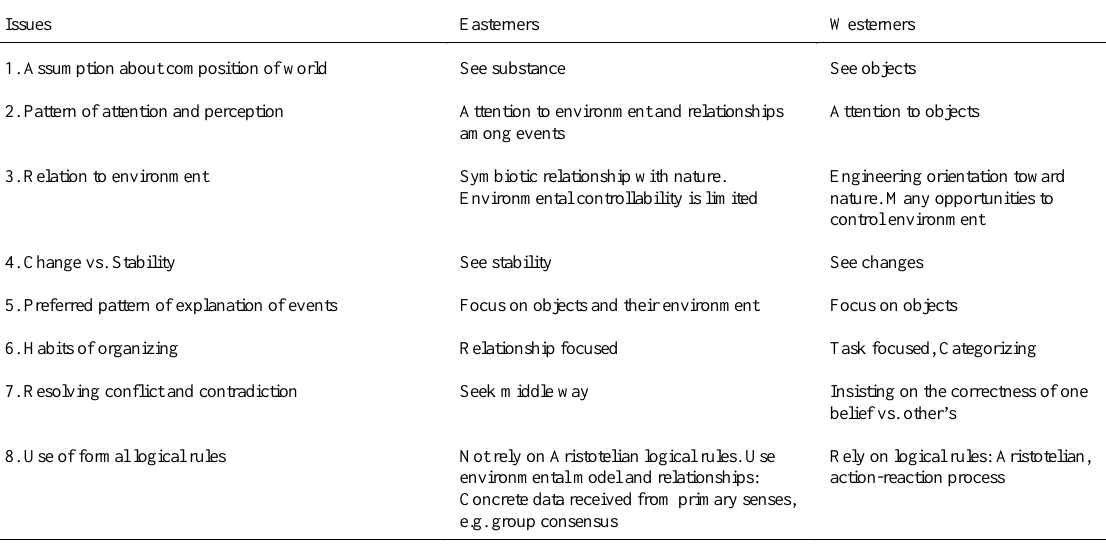
Table 1: Differences between Easterners and